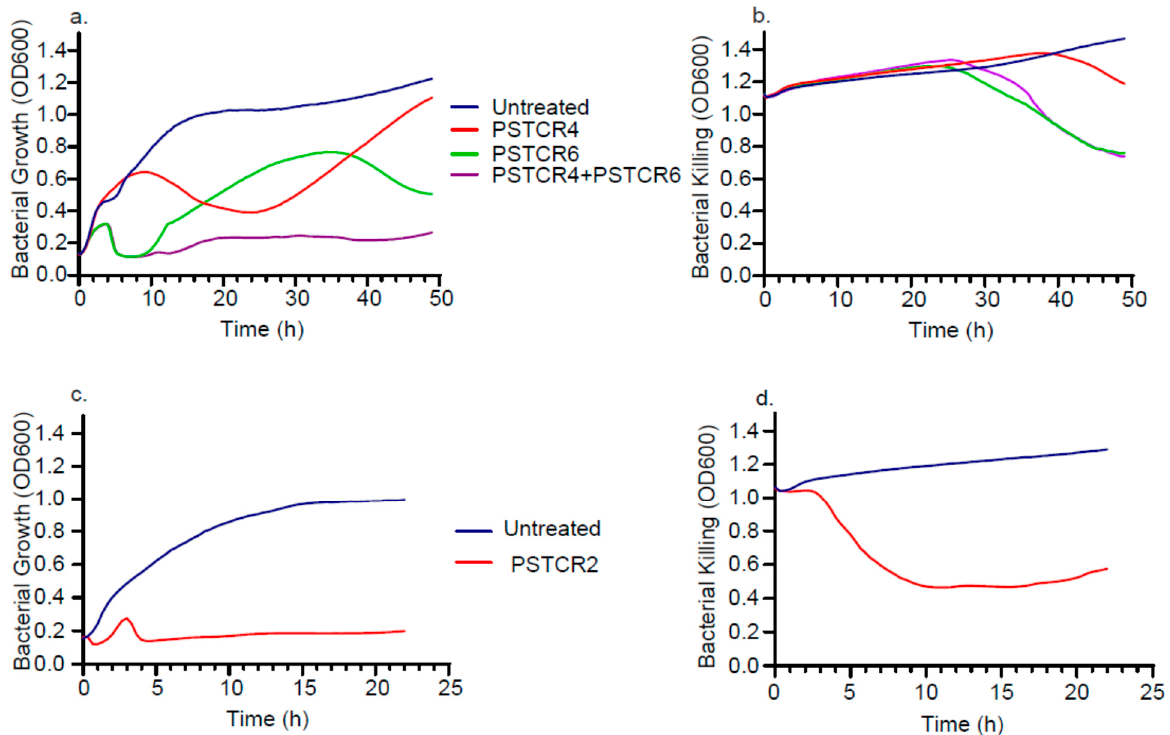
Figure 4. Characterization of lytic activity in liquid cultures. Kinetic growth and killing curves of P.st 8 (blue) at the ( a ) logarithmic and ( b ) stationary stage in the presence of the phages PSTCR4 (red), PSTCR6 (green) and both of them (purple); growth curves of P.rett10 (blue) at the logarithmic ( c ) and killing curves of the stationary ( d ) stage in presence of the phage PSTCR2 (red).